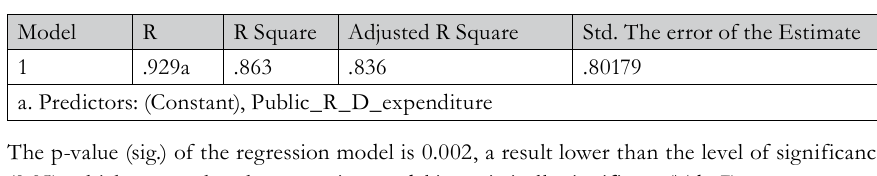
Tab. 6 – Regression model summary – Czech Republic. Source: own processing